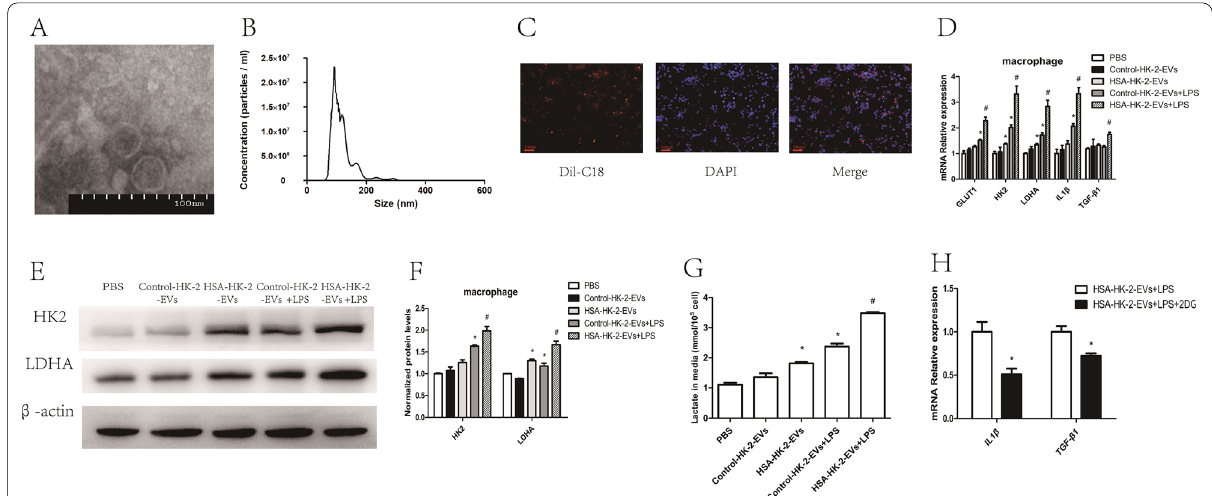
Fig. 3 HSA-treated tubular epithelial cell-derived EVs promoted macrophage glycolysis in vitro. A EV morphology was analyzed using transmission electron microscopy. B EV size distributions were analyzed using nanoparticle tracking analysis. C EVs labeled with Dil-C18 were taken up by macrophages (original magnification 100). Macrophages were co-cultured with EVs: D mRNA levels of GLUT1, HK2, LDHA, IL1β and TGF-β1 (n × E , F protein levels of HK2 and LDHA